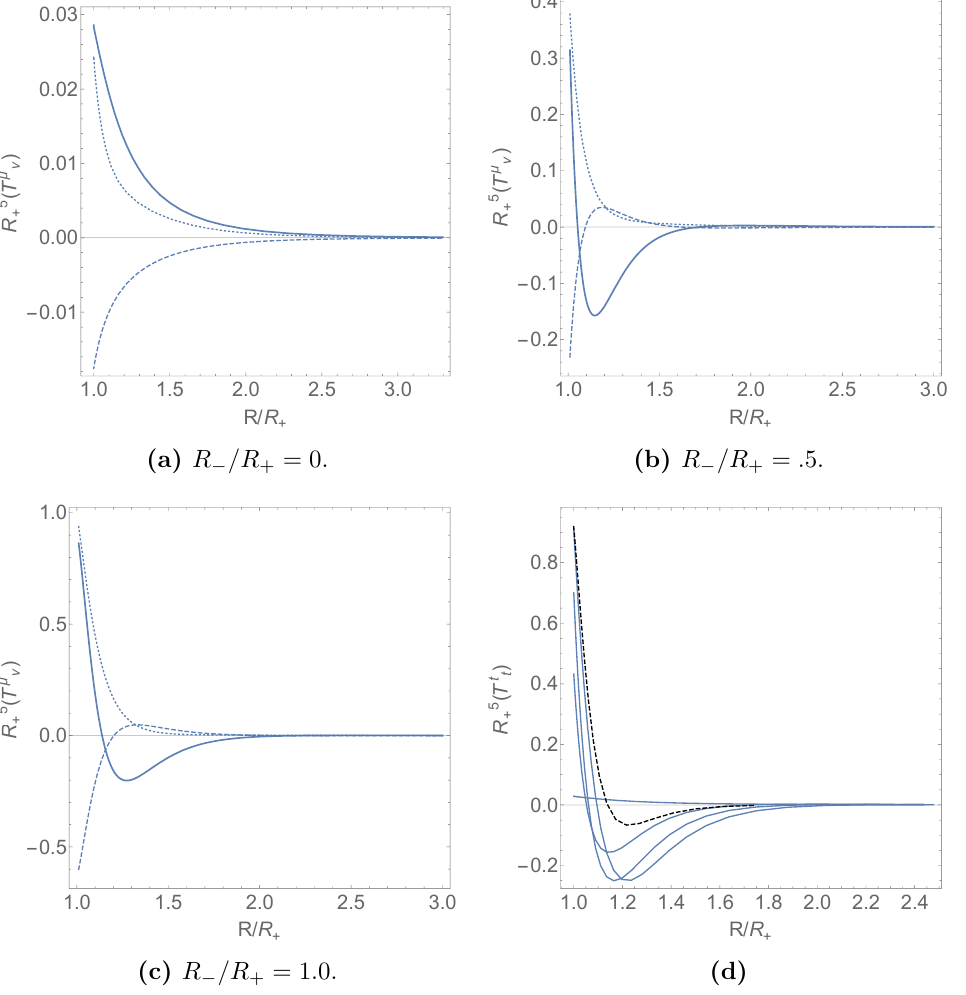
h T (cid:22) i as a function of R for di(cid:11)erent (cid:23) 5 l 4 , the dotted line is T r , and t r